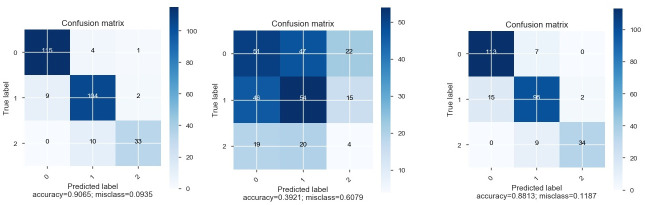
Confusion matrices.